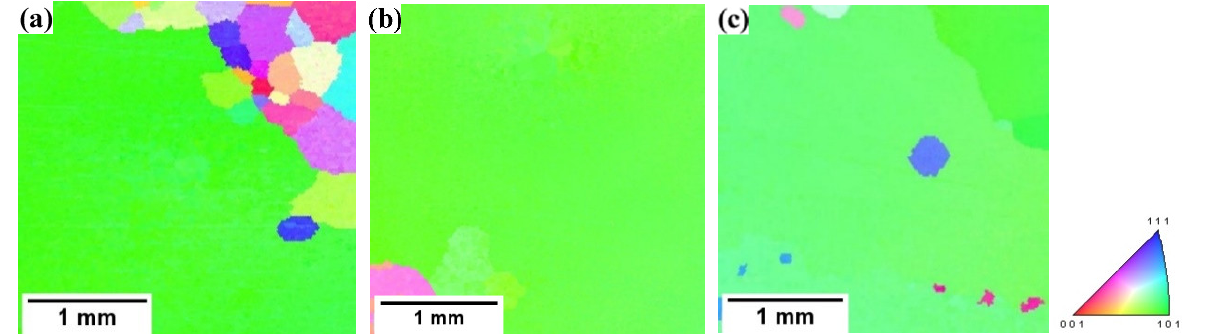
Figure 4. IPF of finally annealed samples in different atmospheres: ( a ) 100%H 2 ; ( b ) 25%H 2 + 75%N 2 ; ( c ) 50%N 2 + 50%H 2 .